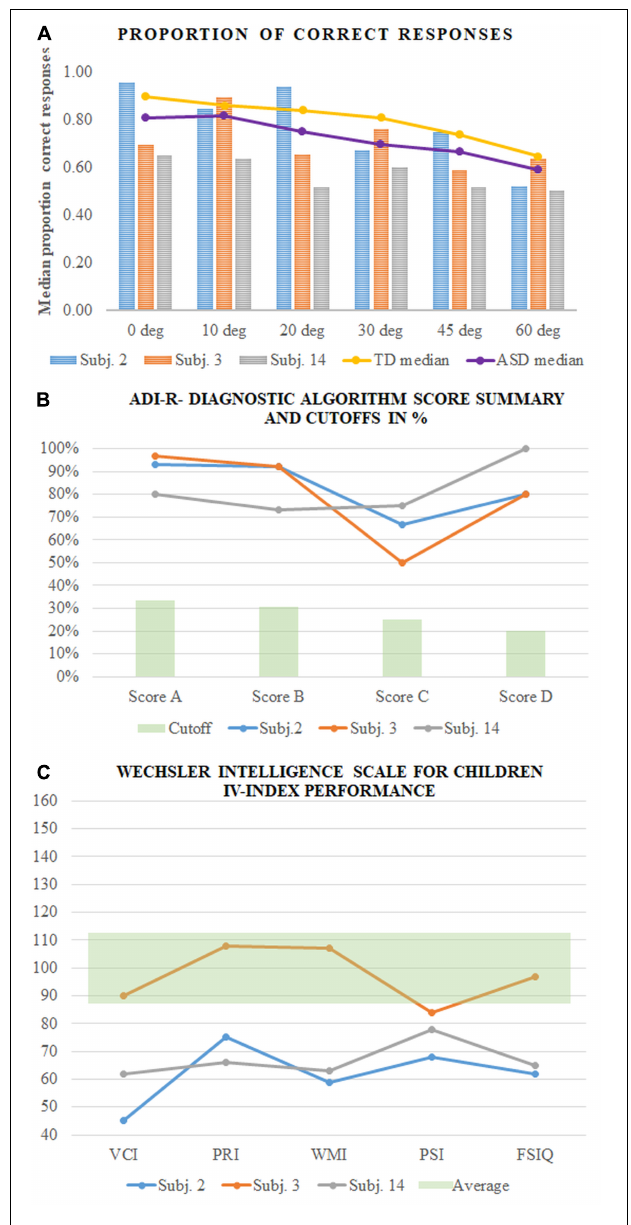
FIGURE 8 | Results of the three participants (Subjs. 2, 3, and 14 in our sample). (A) The proportion of correct responses of each participant compared to the medians of the group with ASD and TD; (B) ADI-R- Diagnostic Algorithm Score Summary and Cutoffs in%; (C) Wechsler Intelligence Scale for Children IV-index